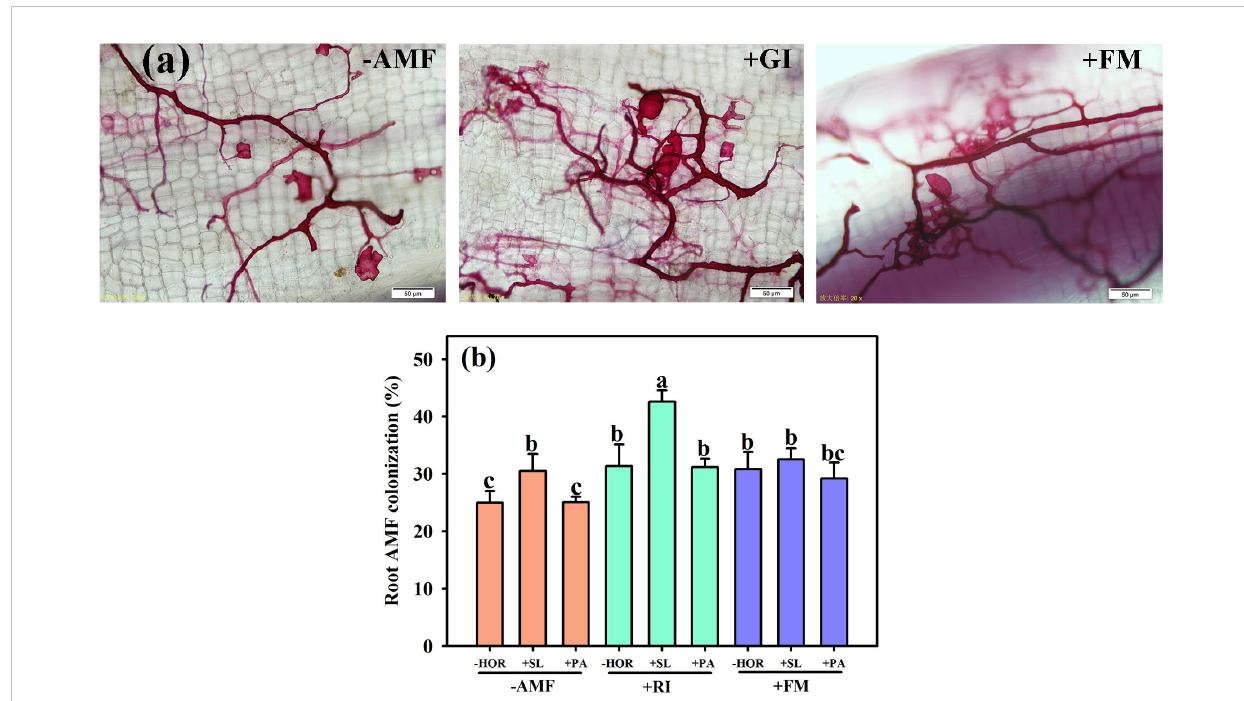
FIGURE 1 AMFs and plant hormones interaction improved the mycorrhizal colonization of tea cutting seedings. (A) The root system colonization structures of AMF. (B) Interaction effect of AMF inoculation and plant hormones on AMF colonization rates. Data bars (means ± SD, n = 3) indicated by different letters suggest signi fi cant differences ( P < 0.05 ). AMF, arbuscular mycorrhizal fungi; RI, Rhizophagus intraradices ; FM, Funneliformis mosseae ; HOR, hormone; SL, strigolactones; PA, spermidine. The same treatments apply to other Figures/Tables. Different lowercase letters in a fi gure indicate that the mean values are signi fi cantly different (P < 0.05) from each other according to LSD